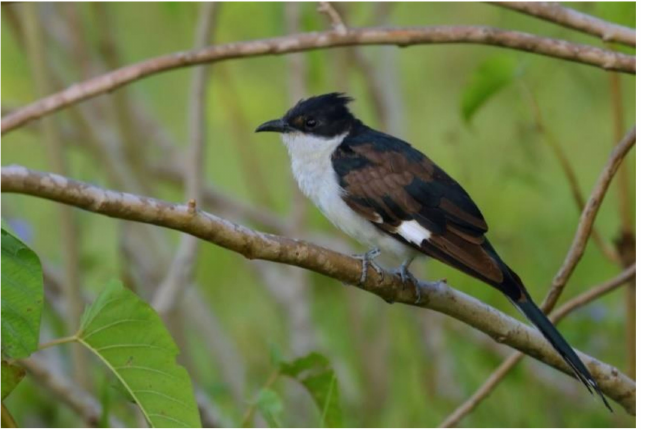
Figure 1. Image of Clamator jacobinus (Jacobin cuckoo or Pied cuckoo) (Source: Pied Cuckoo Macaulay Library